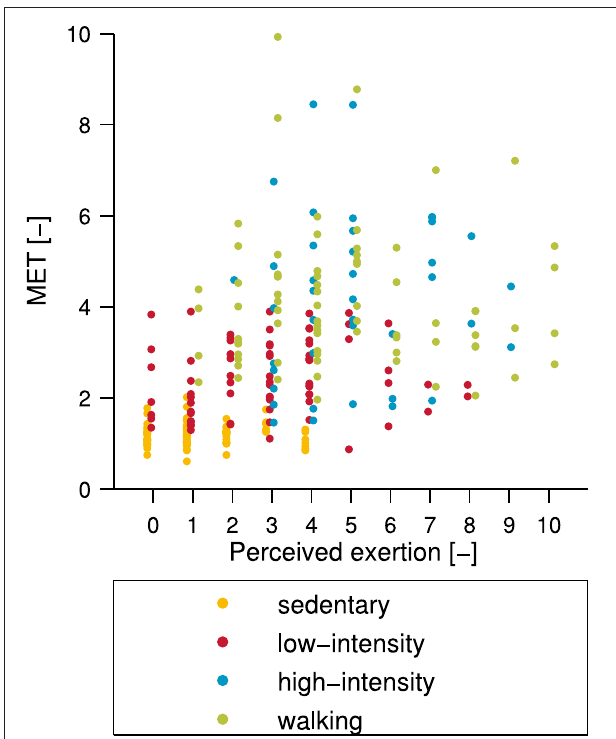
FIGURE 6 | Comparison between subjective perceived exertion and measured metabolic equivalent of task (MET). Note that the subjective perceived exertion was assessed using an 11-point numeric rating scale where 0 represents no exertion and 10 represents maximum exertion. The Spearman rank correlation between perceived exertion and MET was R = 0.60 ( p <